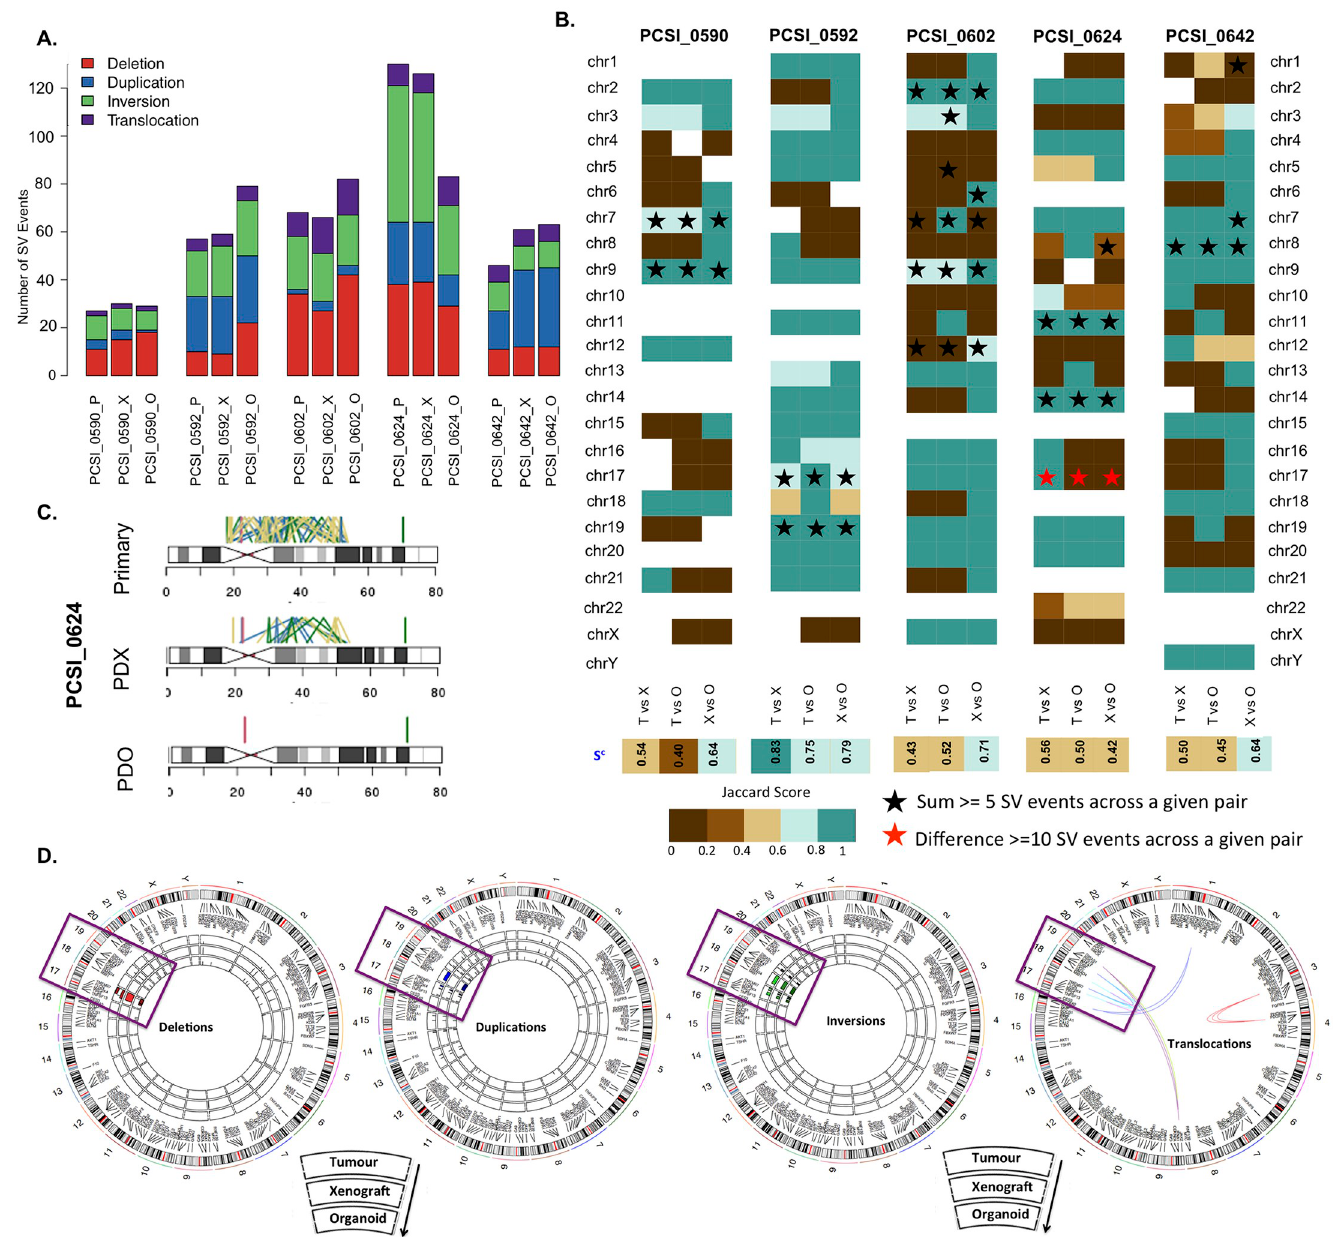
Fig 6. Comparative analysis of structural variation (SV) across tumour-PDX-PDO trios. (A) Distribution of SV events (deletion, duplication, inversion, translocation) in 5 trio samples. The primary (P), PDX (X), and PDO (O) sample for each trio is indicated. B) Chromosome-specific Jaccard indices in 5 primary- PDX-PDO trios. Each trio is split into 3 pairs representing primary-PDX (T vs X), primary-PDO (T vs O) and PDX-PDO (X vs O) comparisons. Chromosomes with an observed large number of rearrangements ( � 5 events) in each pair are indicated (black stars). Chromosomes with a large difference of SV events between a tumour- PDX pair ( � 10 SV events difference) are highlighted (red stars). The overall concordance (S c ) score for each pair across all chromosomes in indicated (bottom row). (C) Comparison of SV events across chromosome 17 of PCSI_0624. This chromosome was discordant between primary-PDX, primary-PDO, and PDX-PDO pairs. (D) Distribution of SV events across the primary tumour, matched PDX, and matched PDO samples of the PCSI_0592 trio. Each type of SV (deletion, inversion, duplication, and translocation) is represented as one circos plot, with 3 rings indicating tumour (outer), PDX (middle), and PDO (inner). Chromosomes demonstrating chromothripsis are highlighted in